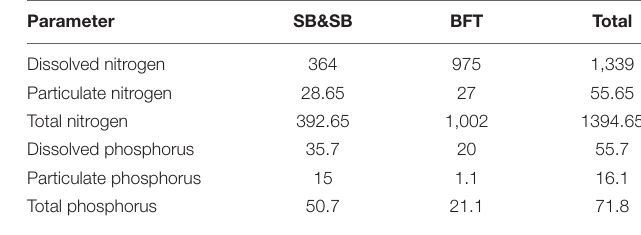
TABLE 1 | Discharge of nitrogen and phosphorus (tonnes/year) from fish farms (SB&SB – seabass and seabream farming; BFT – bluefin tuna farming) in the Croatian waters of the Adriatic Sea (Kušpili´c et al.,